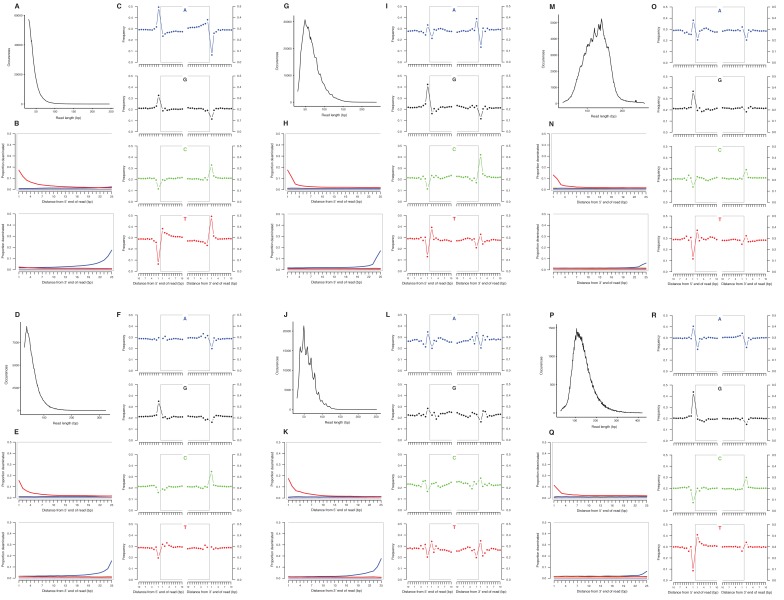
Characterization of ancient nuclear DNA damage patterns from six H. francisci samples.(A–C) JK166 (LACM(CIT) 109/150807; Nevada), (D–F) JK260 (KU 47800; Wyoming), (G–I) PH013 (YG 130.6; Yukon), (J–L) PH036 (YG 76.2; Yukon), (M–O) MS349 (YG 130.55; Yukon), (P–R) MS439 (YG 401.387; Yukon). Every third panel: (A) to (P) DNA fragment length distributions; (B) to (Q) proportion of cytosines that are deaminated at fragment ends (red: cytosine → thymine; blue: guanine → adenine); and (C) to (R) mean base frequencies immediately upstream and downstream of the 5’ and 3’ ends of mapped reads.